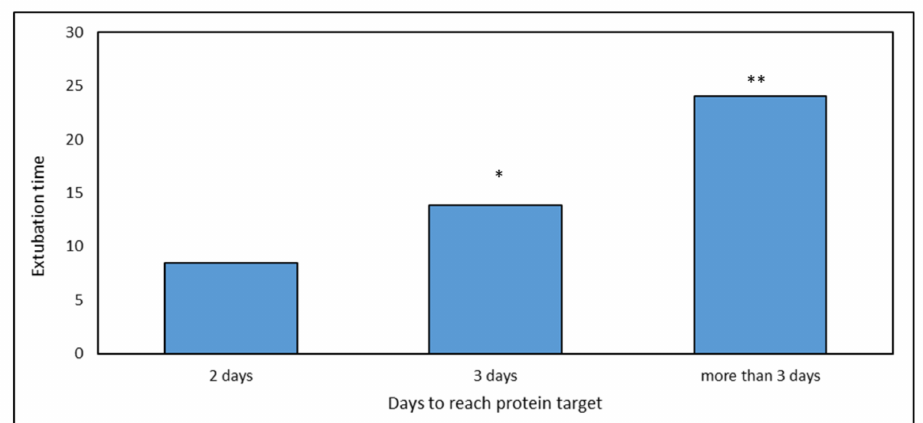
Figure 7. Extubation time related to different PT thresholds. There was a significant correlation between time to reach PT and extubation time (*, **, both p <